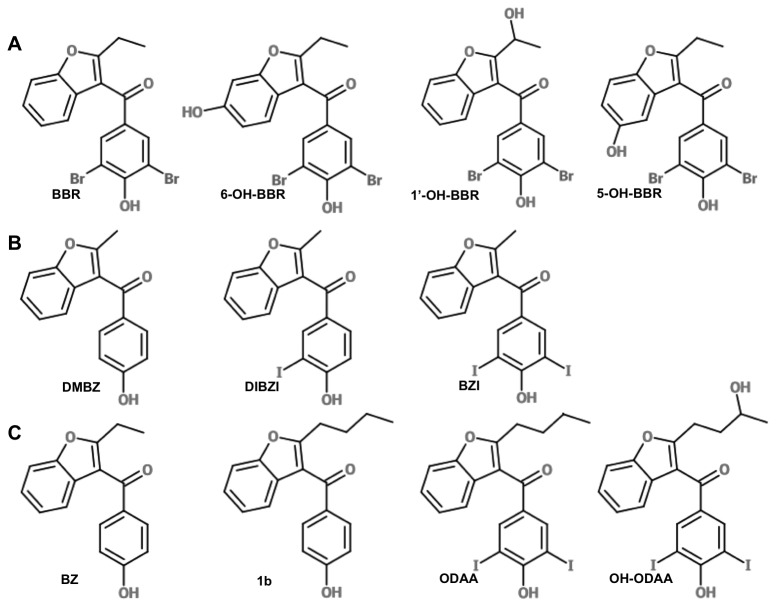
Chemical structures of compounds tested as EYA3 inhibitors and anti-angiogenic agents.(A) Metabolites of BBR. (B) Alternate halogenation of the phenol ring. (C) Alternate substituents at position 2 of the benzofuran.